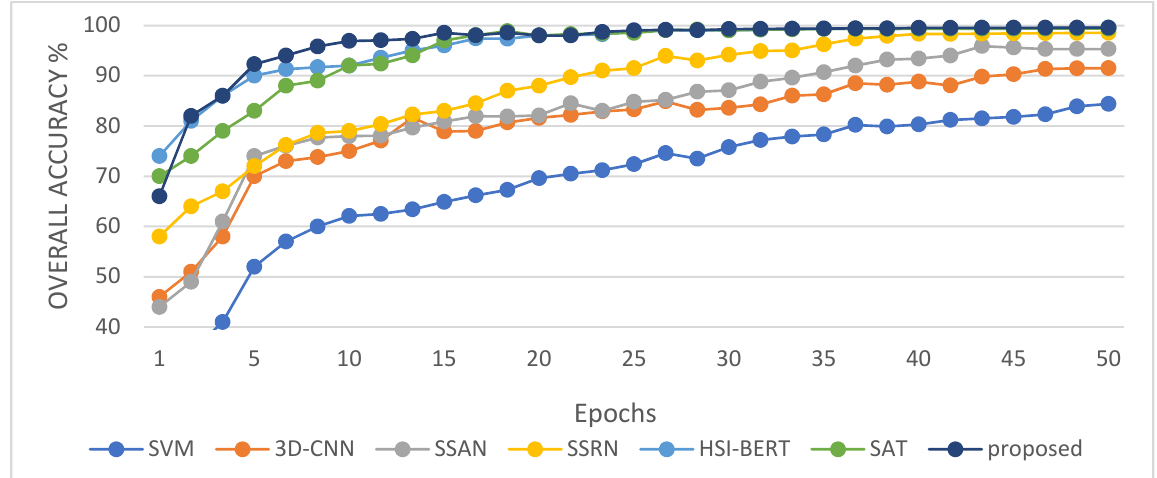
Figure 12. Overall accuracy curve of different models in IN dataset.